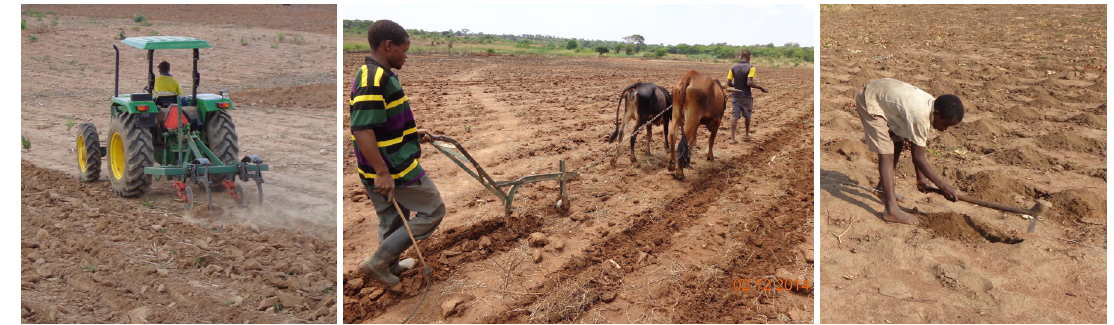
Figure 9. Conservation tillage: tractor ripping, ox ripping, and digging of planting basins (photo: K.B. Esser).